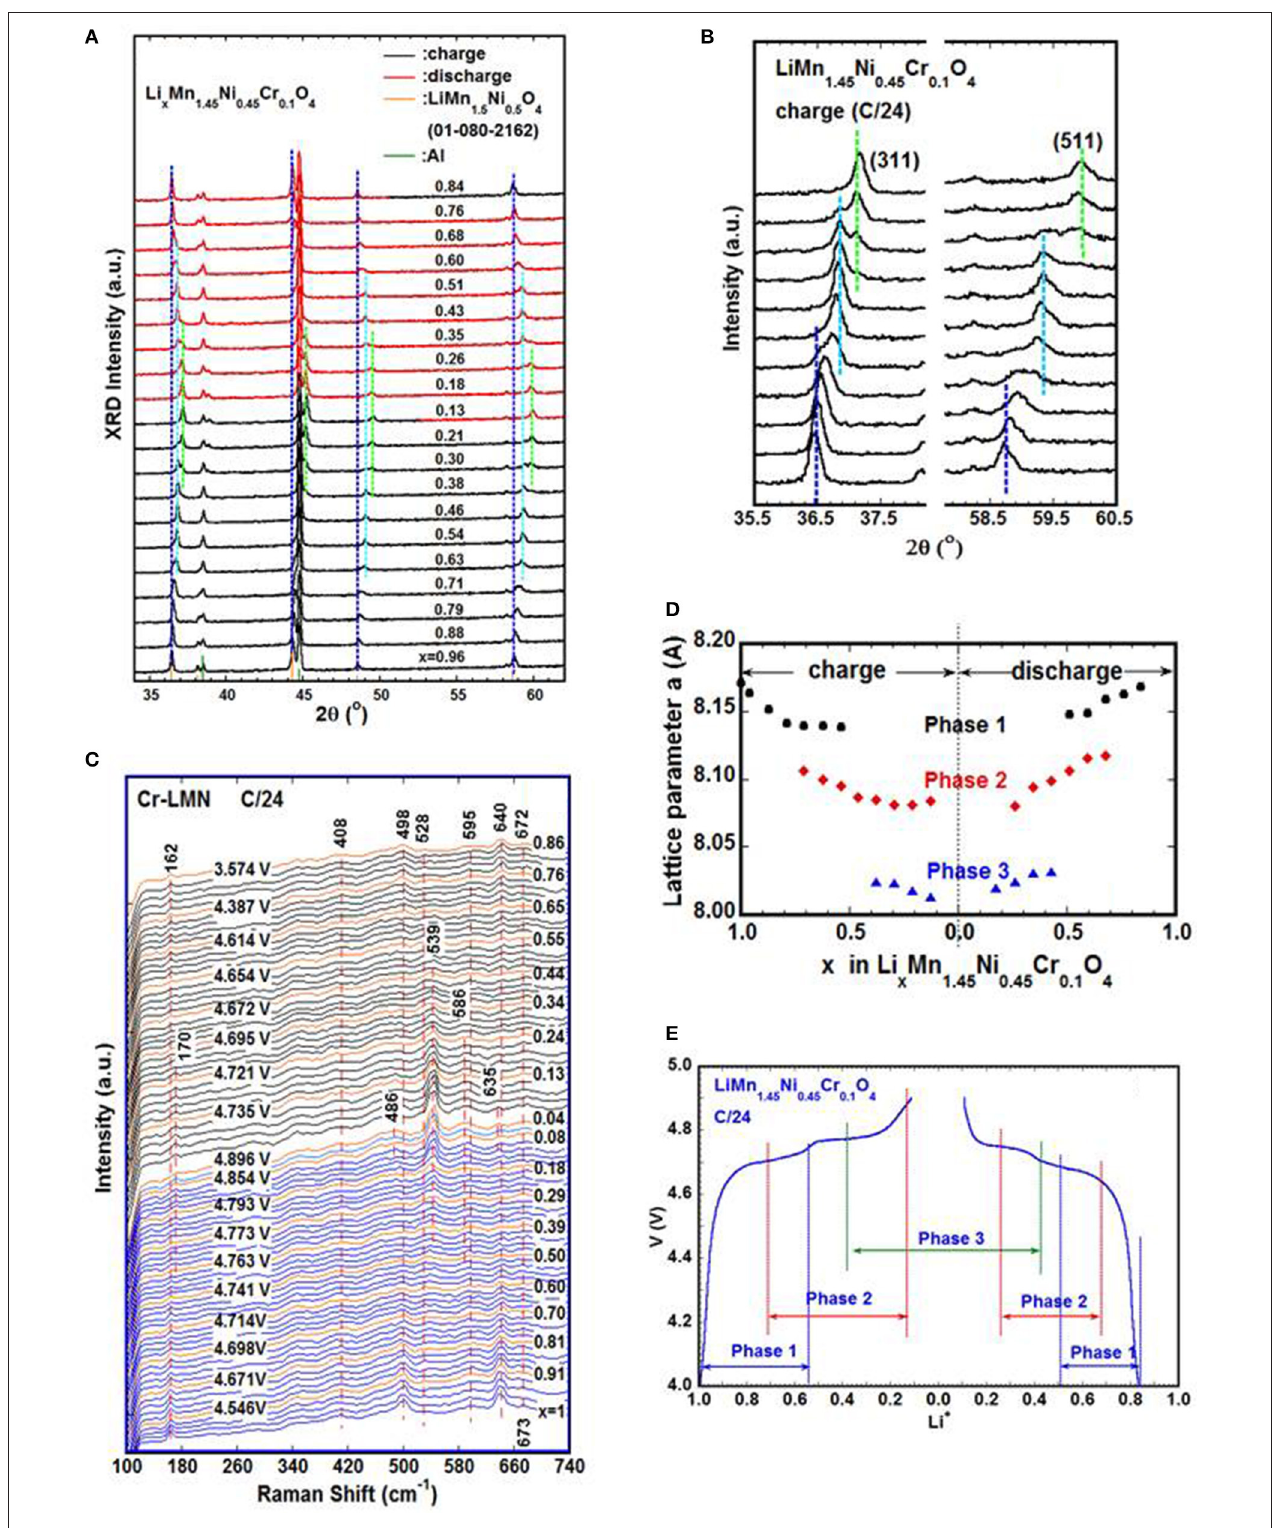
FIGURE 3 | Operando XRD (Zhu W. et al., 2013) and Raman (Zhu et al., 2015) measurements on Li x Mn 1.45 Ni 0.45 Cr 0.1 O 4 cathodes during galvanostatic cycle at C/24; (A) Evolution of XRD patterns as a function of lithium concentration; (B) XRD patterns focused on (311) and (511) peaks which clearly show the three different phases present during charge; (C) Development of Raman spectra during cycle, the appearance of new bands at 170 and 539 cm − 1 toward the end of charge